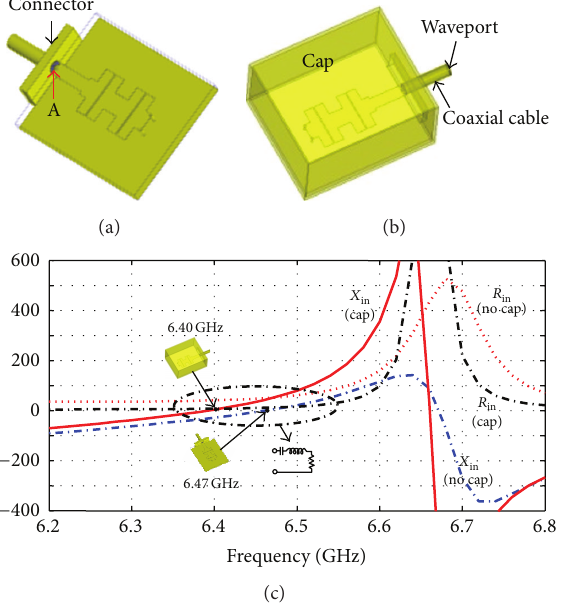
Figure 4: Detailed EM model of (a) the antenna and (b) the WC on the antenna, along with (c) the simulated 𝑍 in ( Ω ) of (a), with and without the WC; the WC electrical dimensions are ∼0.60𝜆 × 0.52𝜆×0.32𝜆 ; connector and cable dimensions are given in the text. Connector housing details are as in Figure 5.